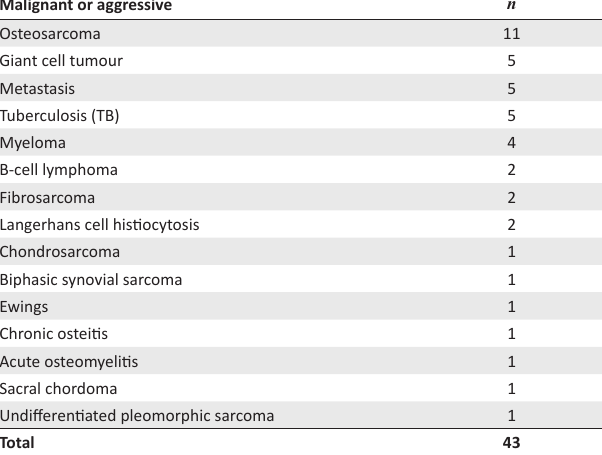
TABLE 1: Summary of histologically malignant/aggressive of infective lesions ( n = 43). Malignant or aggressive n